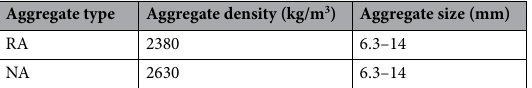
Table 7. RA and NA size and oven-dried